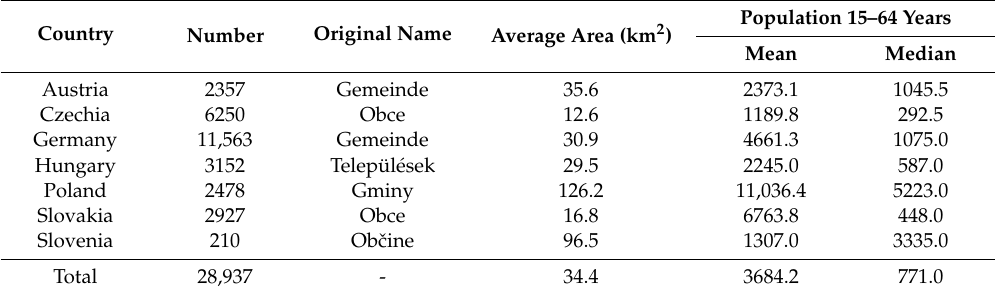
Table 1. Municipalities (LAU2 units) in studied countries.